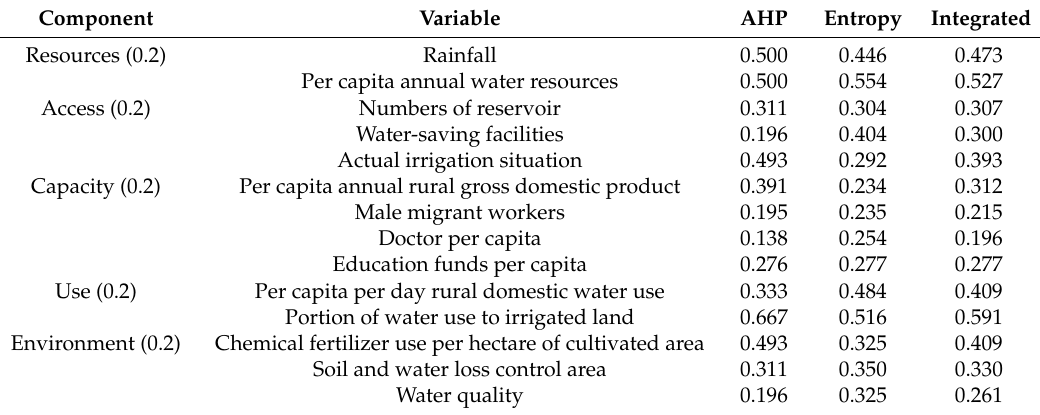
Table 2. Subjective weights, objective weights, and integrated weights of the WPI components, indicators, and